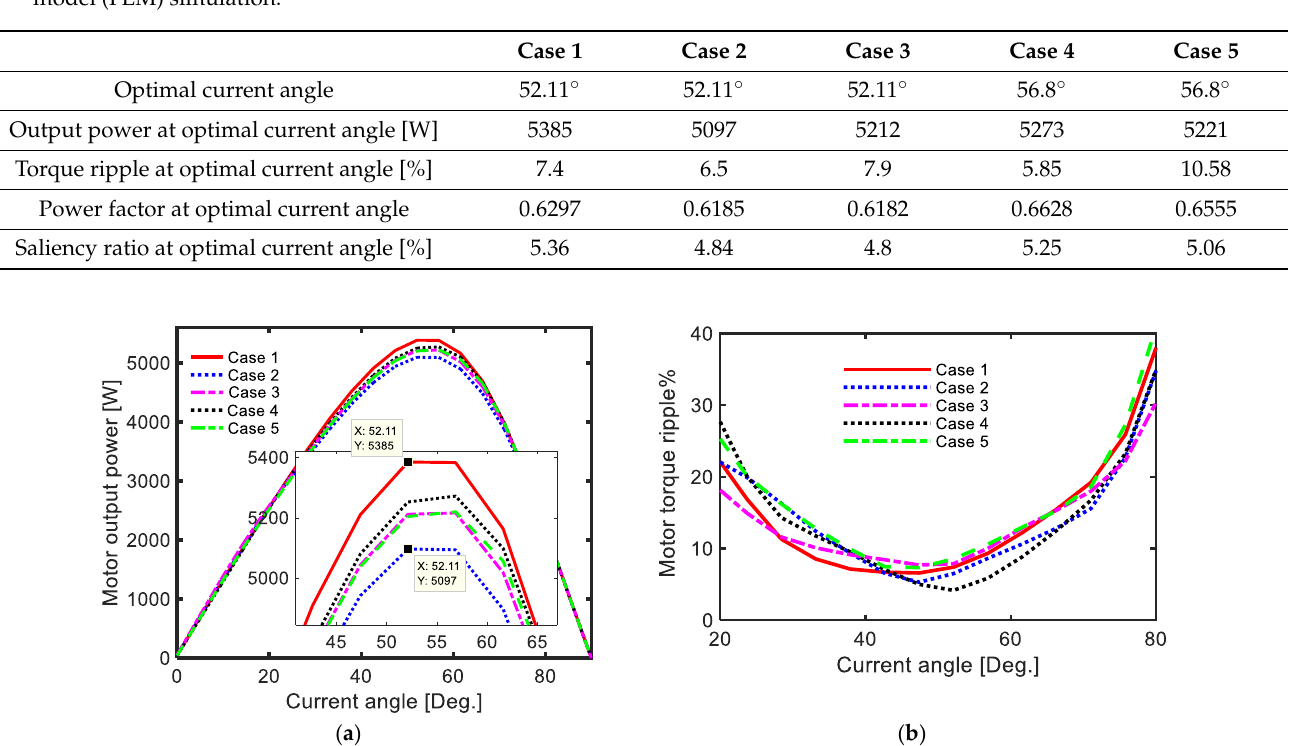
Table 5. Performance of the optimal geometry for different case studies of the three-phase SynRM using finite element model (FEM) simulation.